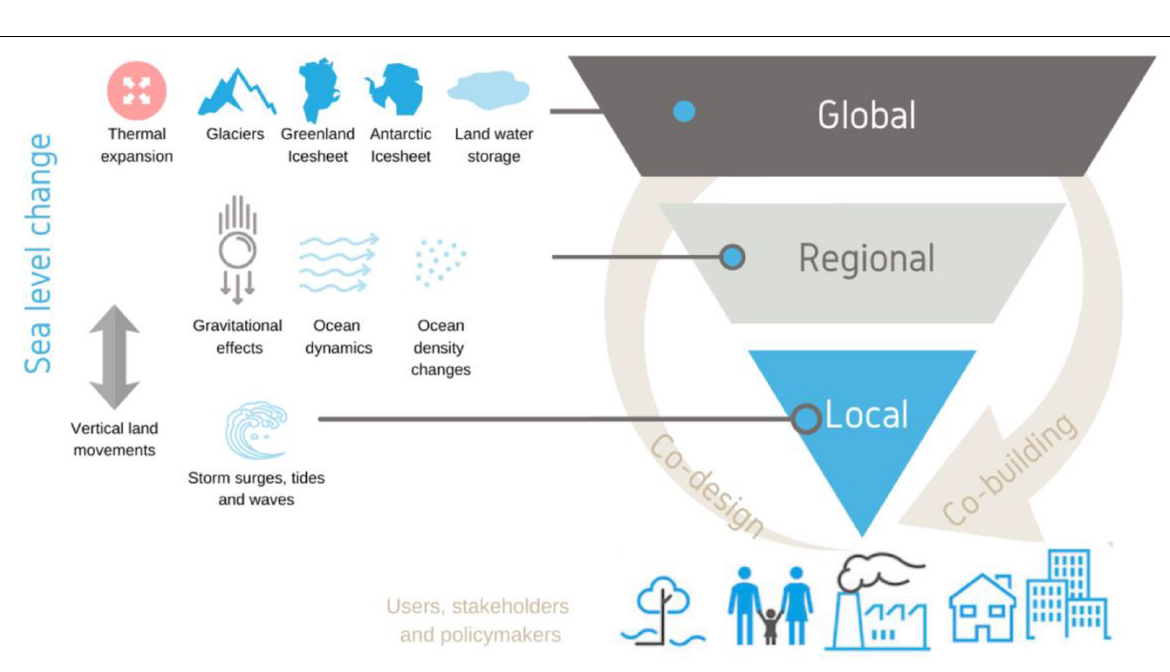
Frontiers in Marine Science |